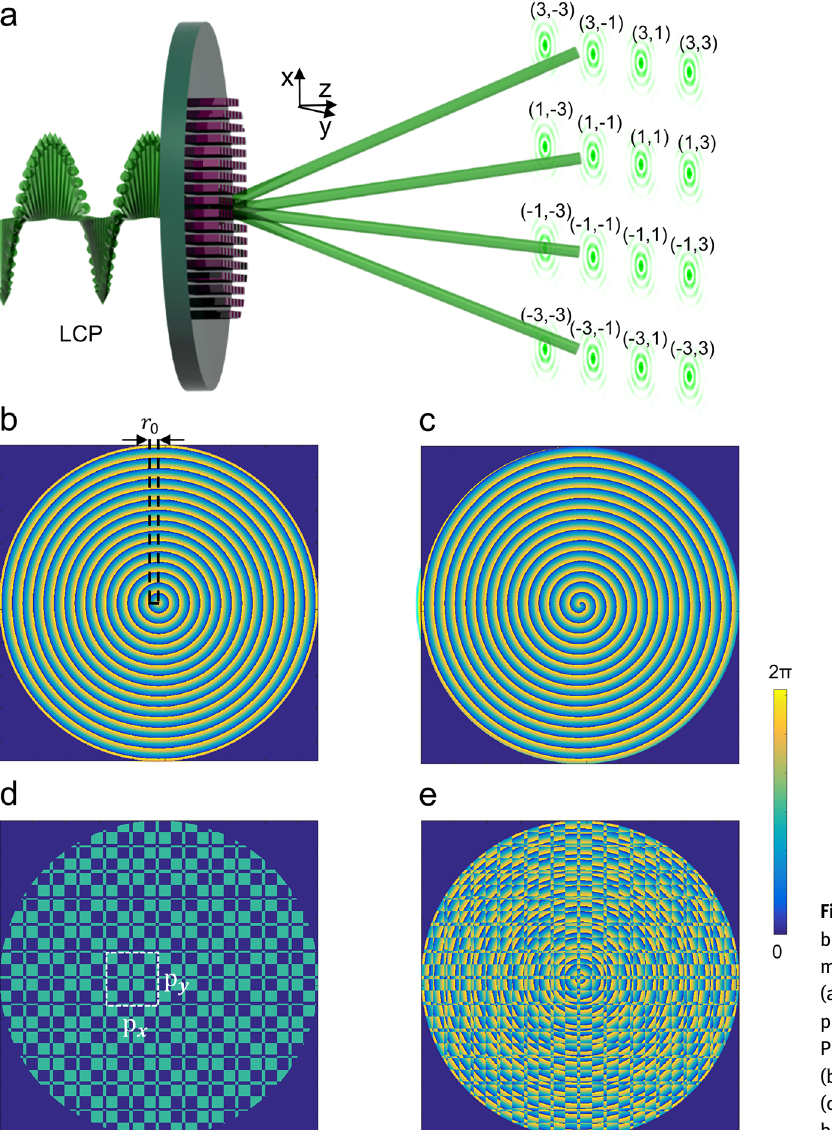
Figure 1: Generation principle of Bessel beam arrays through dielectric